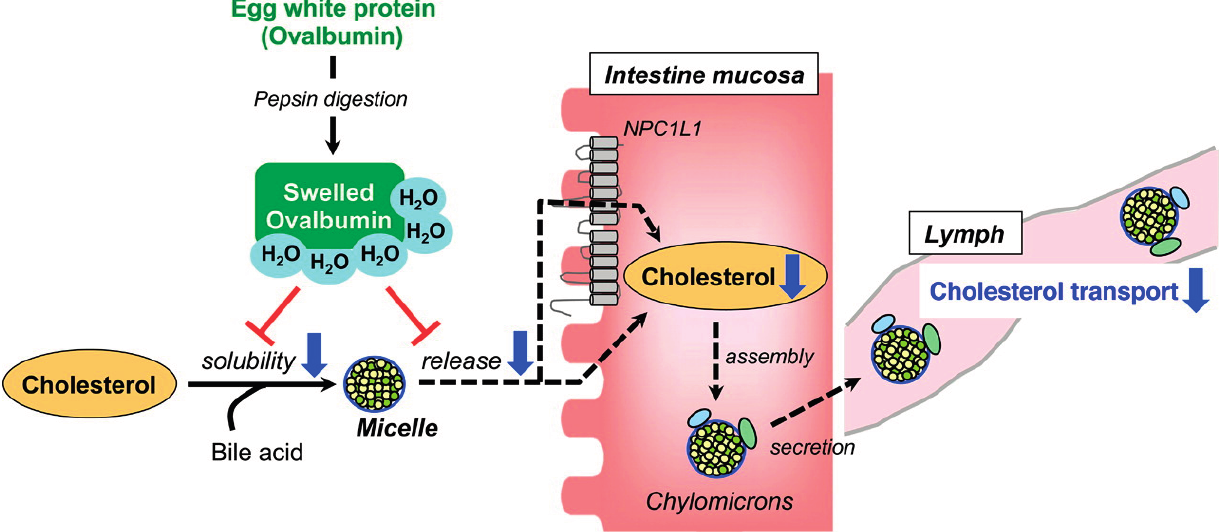
Figure 2. The role of egg white protein digested with pepsin on intestinal and lymphatic uptake of dietary cholesterol in rats. Reprinted from [30] with permission form American Chemical Society, copyright